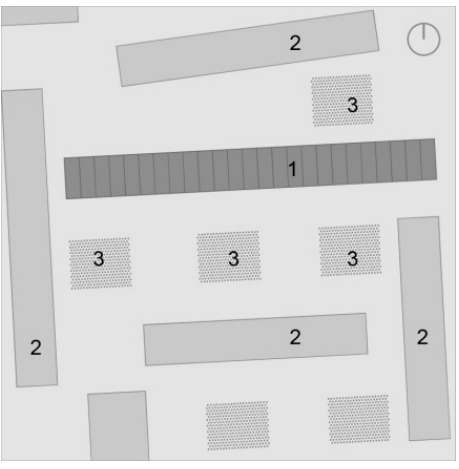
Figure 1. Building arrangement in the site. 1: investigated building; 2: surrounding buildings; 3: existing green